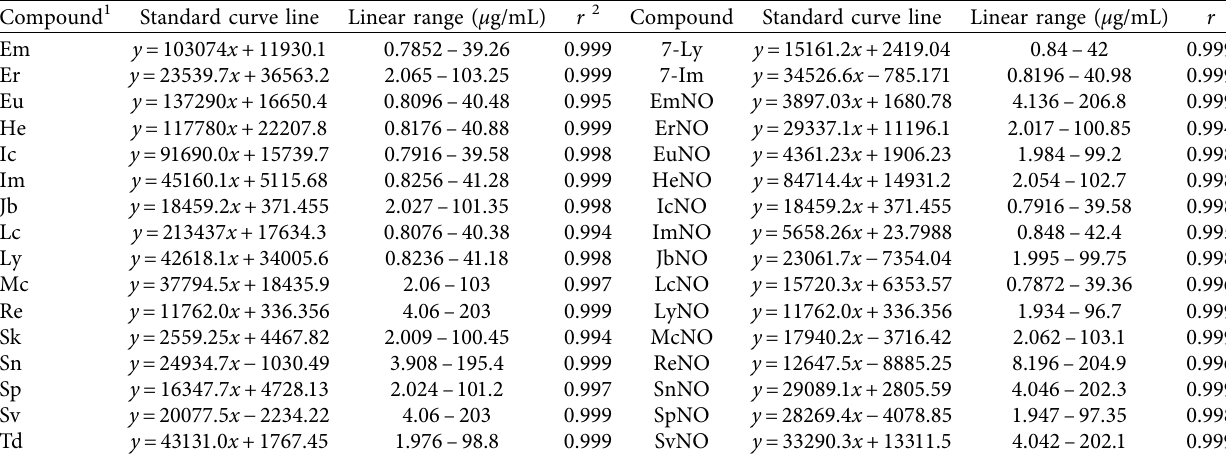
Table 2: Standard curve, linear range, and R for PAs in the XYT.